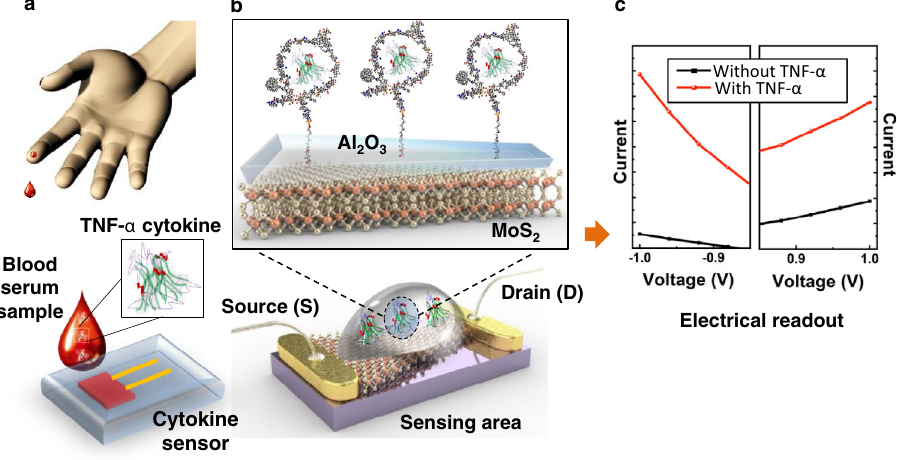
Fig. 1 | Schematic illustration of the concept of the cytokine sensor operation. a A small volume of blood serum is drop casted onto the sensing area. b The cytokine sensor consists of an asymmetric geometry MoS 2 crystal contacted by two metal electrodes. The inset shows a magni fi ed diagram of the sensing area showing how TNF- α cytokines are bound to aptamer